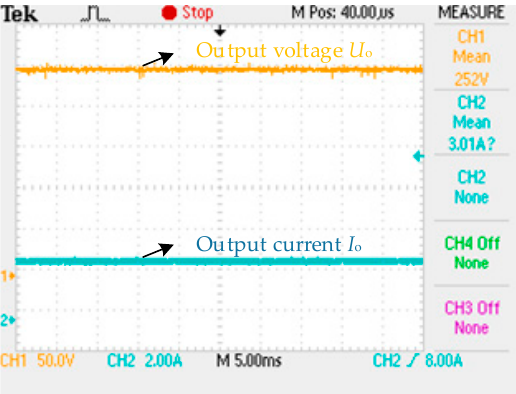
Figure 18. The output voltage and current waveforms in the primary side at constant voltage stage.